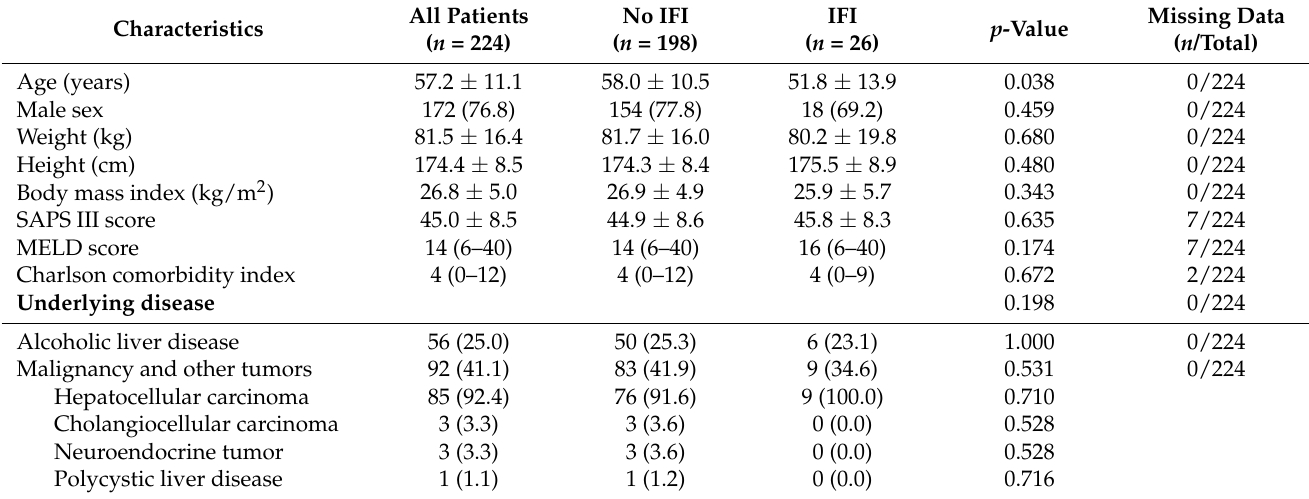
Figure 1. Flowchart of patient selection. OLT: orthotopic liver transplantation. The mean age of the analyzed population was 57 ± 11 years, with 77% being males ( n = 172). Included patients had a median Charlson comorbidity index of 4 (0–12), a MELD score of 14 (6–40), and a mean SAPS III score of 45 ± 9. The baseline demographic and clinical characteristics are summarized in Table 2. Table 2. Sociodemographic and clinical characteristics of included patients ( n = 224).